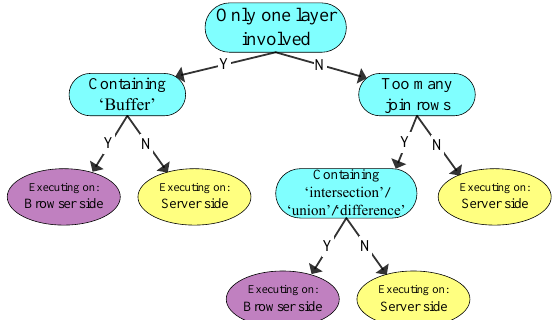
Figure 2. Decision tree for the case when all the needed input